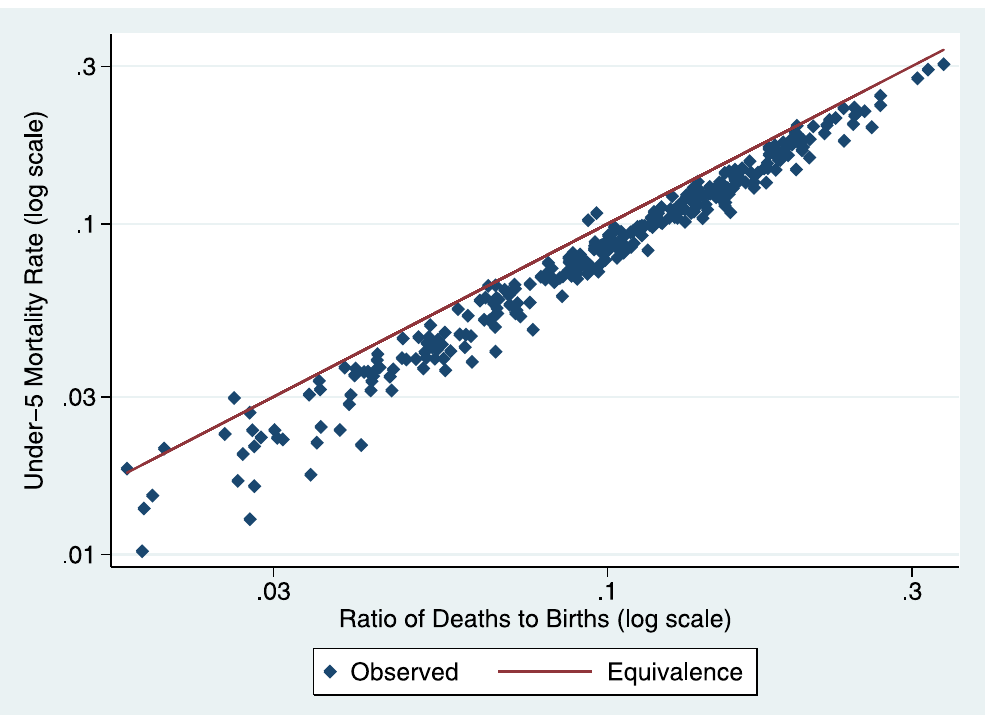
Fig 3. Relationship between ratios of cumulated cohort changes in CD to CEB and U5MR in DHS: Two Year Period (log scale). doi:10.1371/journal.pone.0137713.g003 are presented for survey intervals of both one year and two years. The first and third columns show the regressions without controls, the second and fourth with controls. The simple rela- tionship between ln(U5MR) and ln(c-CD/c-CEB) is close to one to one (Figs 1 and 2), with intercepts close to 0 and slopes only slightly greater than one; the simple relationship accounts for over 95% of the variance in ln(U5MR). Three of the control variables (female age